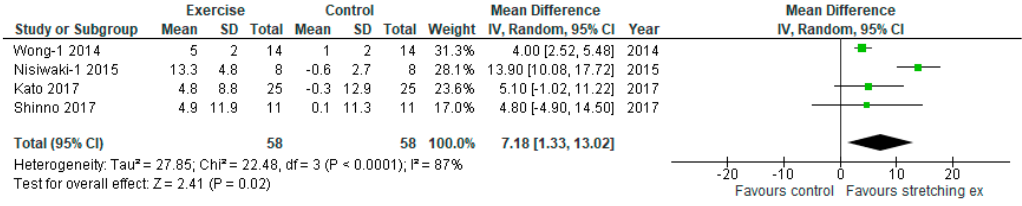
Figure 9. Forest plot comparing changes in muscle flexibility following stretching exercises to non-exercise controls. SD, standard deviation; IV, inverse variance; CI, confidence interval.